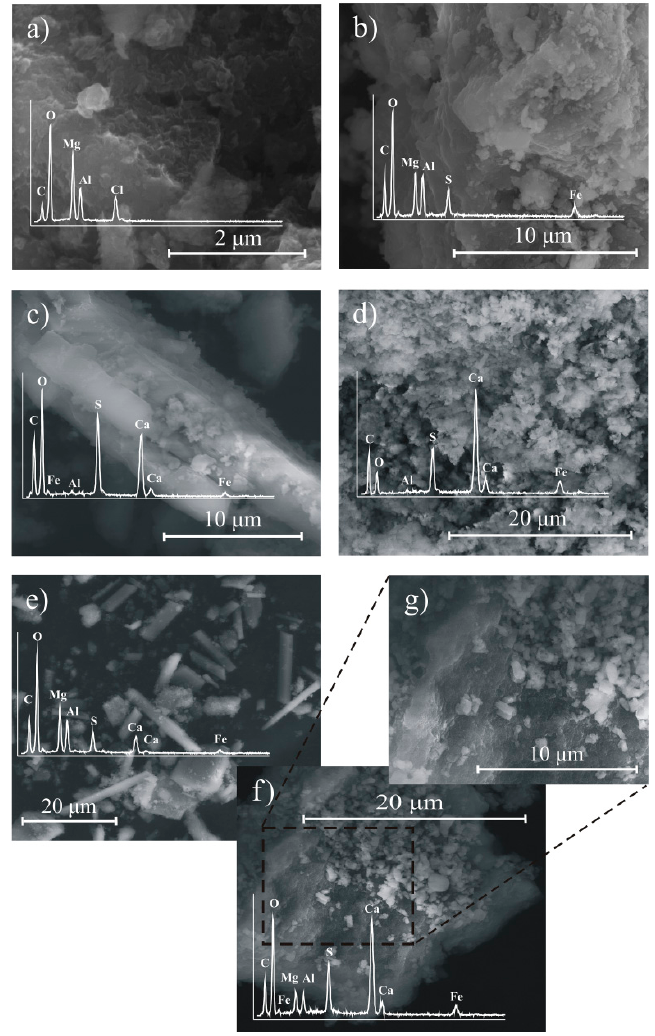
/ L), and solid phase